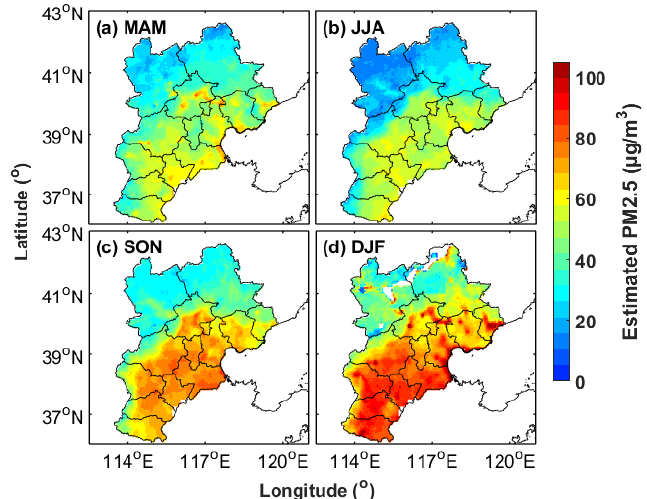
Figure 8. Spatial distribution of seasonally-averaged PM2.5 estimations obtained from the improved LME model.